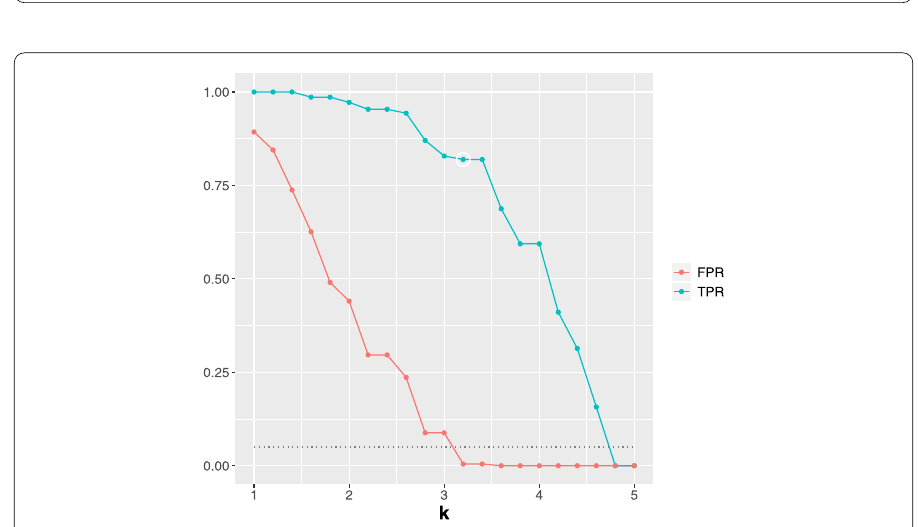
Figure 6 The TPR and FPR for the TD. We show the TPR and FPR as a function of k . Here, the white circle also represents the maximum of TPR among FPR ≤ 0.05